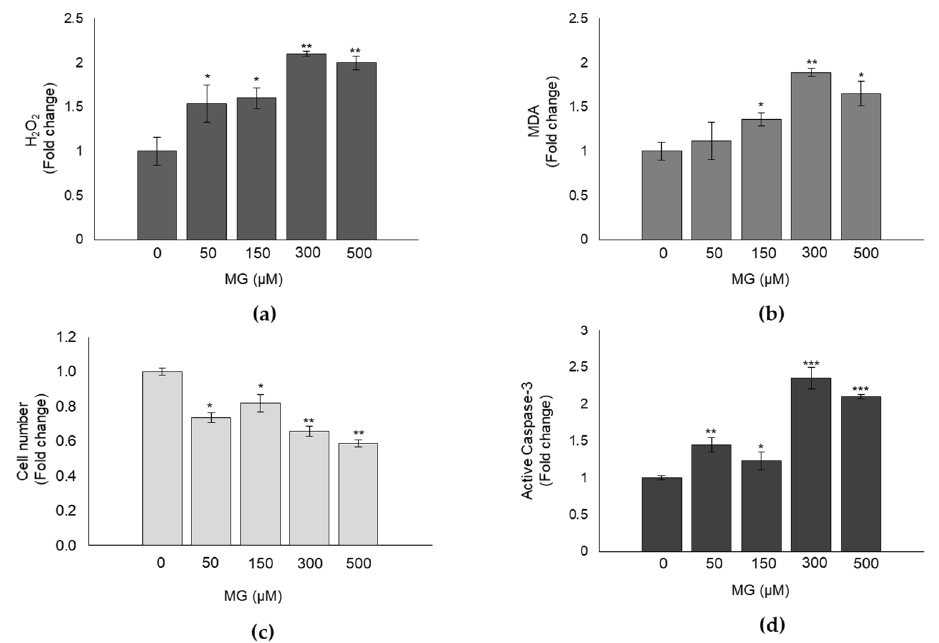
Figure 2. MG induces oxidative stress in DPSCs and impairs cell growth. ( a ) Hydrogen peroxide (H 2 O 2 ) and ( b ) malondialdehyde (MDA) intracellular levels of untreated and MG-treated DPSCs. ( c ) MG determined a significant cytotoxic effect already at 50 µM concomitantly with ( d ) a significant increase of active caspase-3 expression. Histograms indicate the means ± SD of three different cultures, each of which was tested in triplicate. * p < 0.05, ** p < 0.01, and *** p < 0.001, significantly different from control untreated cells.